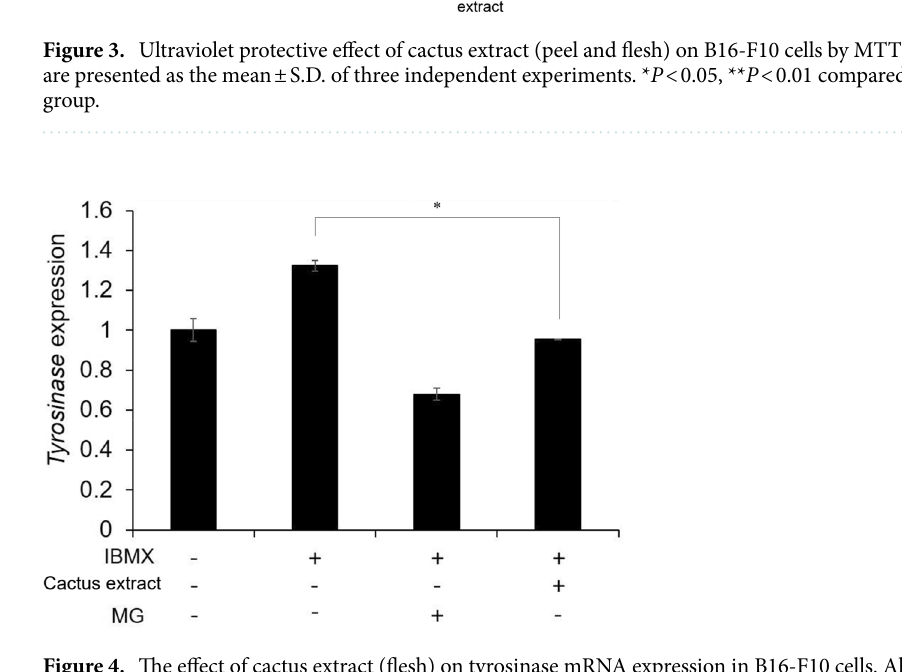
Figure 4. The effect of cactus extract (flesh) on tyrosinase mRNA expression in B16-F10 cells. All data are presented as the mean ± S.D. of three independent experiments. * P < 0.05, ** P < 0.01 compared with control